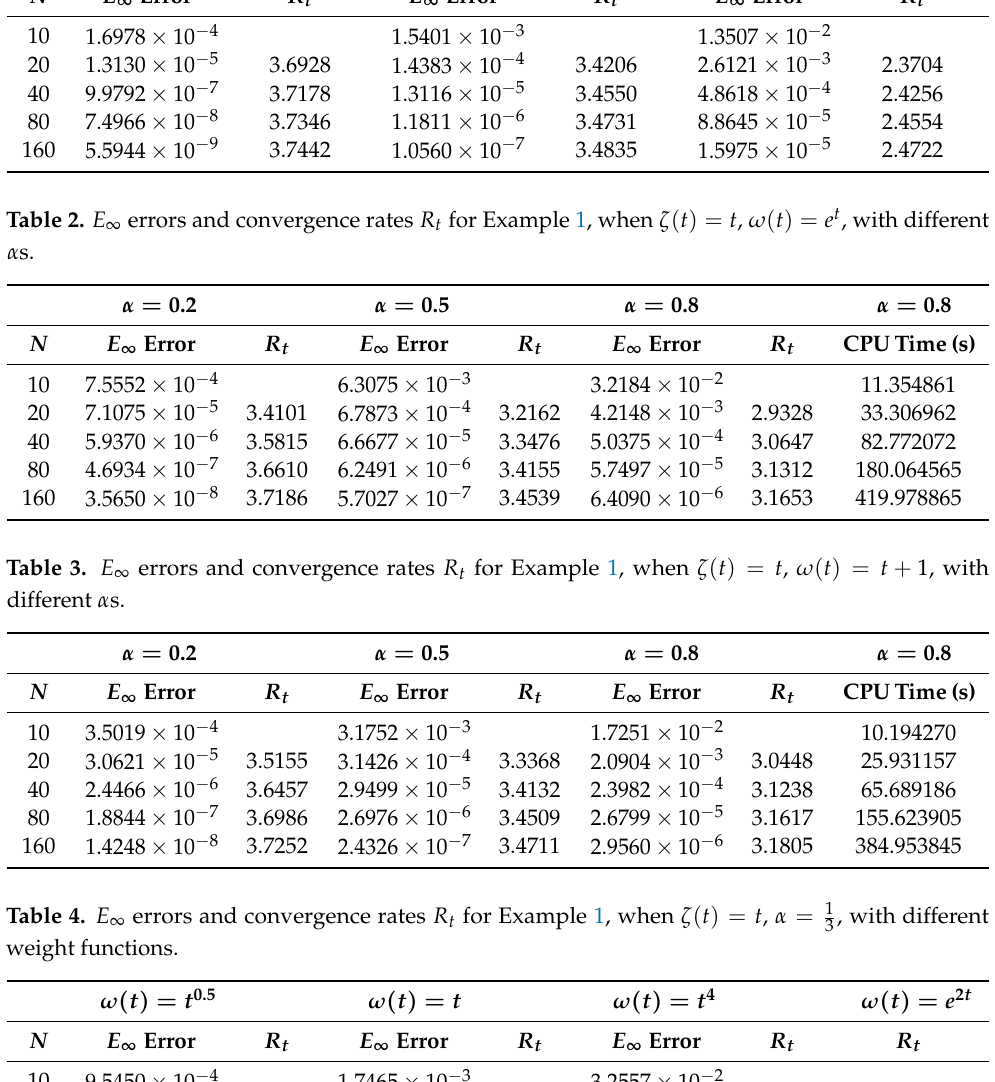
Table 1. E ∞ errors and convergence rates R t for Example 1, when ζ ( t ) = t , ω ( t ) = 1, with different α s.